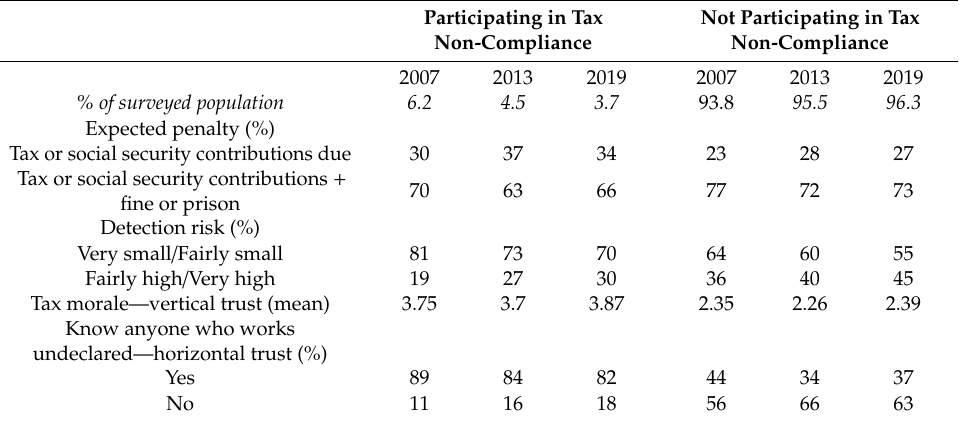
Table 2. Descriptive statistics for the tax non-compliant and non-compliant in